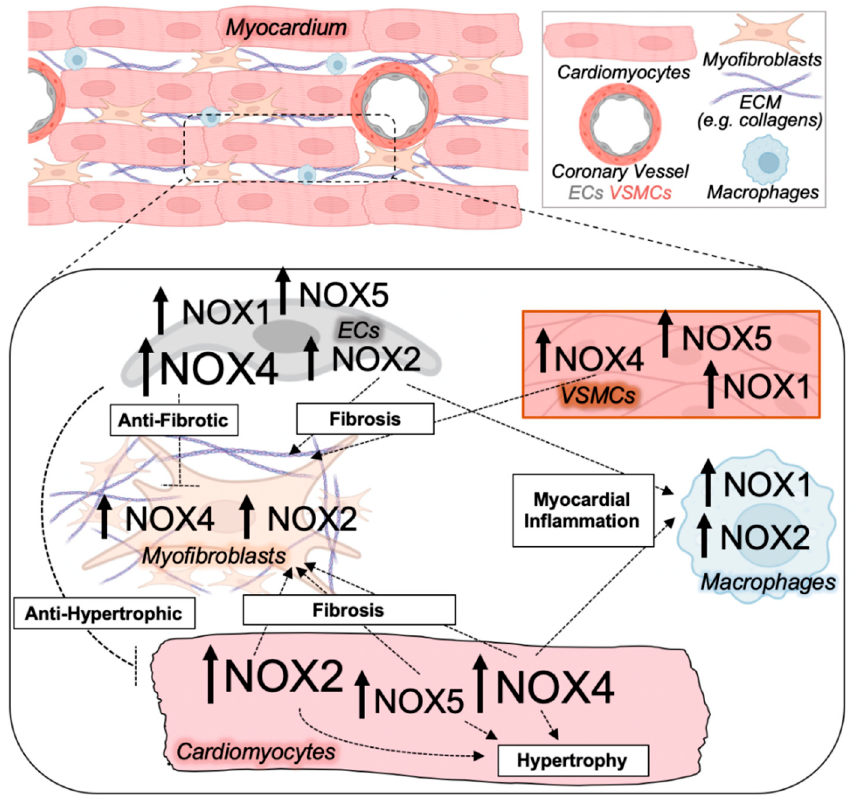
Figure 1. NOX isoform upregulation and crosstalk between cell types in pathological cardiac re- modeling. The diseased myocardium is composed of several cell types all expressing NOX enzymes, including cardiomyocytes, activated myofibroblasts that deposit collagen and extracellular matrix (ECM) components, macrophages, and endothelial cells (ECs), as well as vascular smooth muscle cells (VSMCs) that make up the coronary vessels. NOX isoform activity and ROS production in various cell types of the heart mediate paracrine effects on other cardiac cell types to impact my- ocardial growth, inflammation, microvascular dysfunction, and fibrosis central to adverse cardiac remodeling. Magnitude and directionality of alterations in NOX isoform activity and/or expression in the indicated cardiac cell types are depicted by the font size and arrow, respectively.